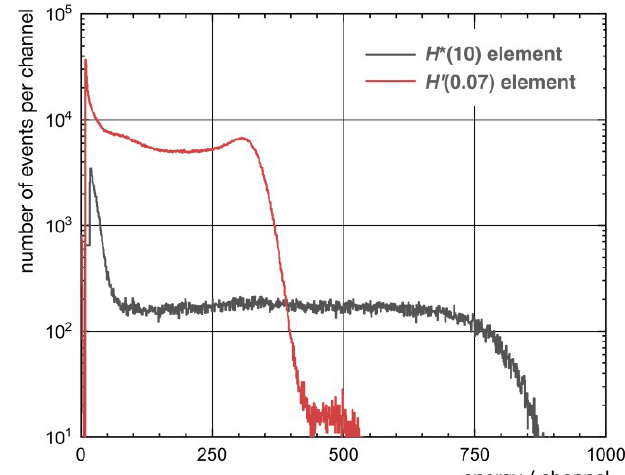
Figure 6. The pulse-charge histograms for the two individual detector elements (gray: H *(10) element, red: H ´(0.07) element) measured during the irradiation with a 137 Cs source. The Compton edges are clearly visible.